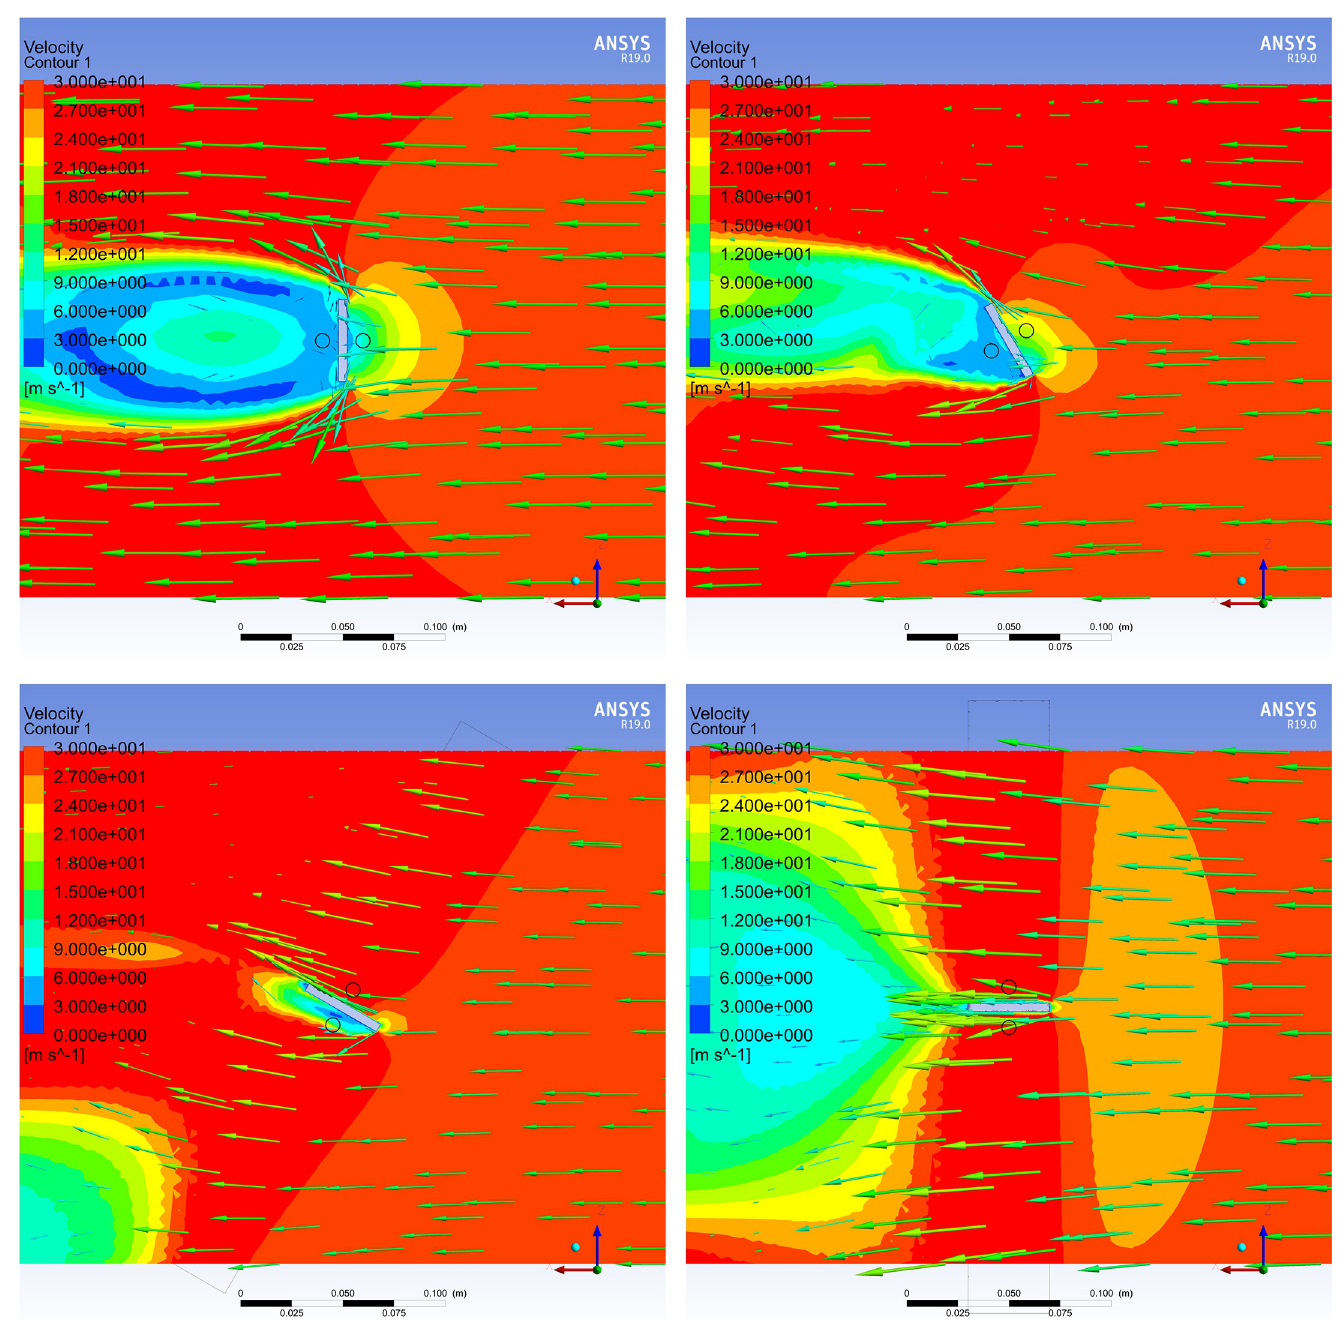
Fig 7. Airflow distribution of the damper board with different angles between the airflow tunnel and external wind vector. Results for angles of (A) 0˚ and 90˚, (B) 30˚ and 120˚, (C) 60˚ and 150˚, and (D) 90˚ and 180˚ between the airflow tunnel and wind vector and between the damper board and wind vector,